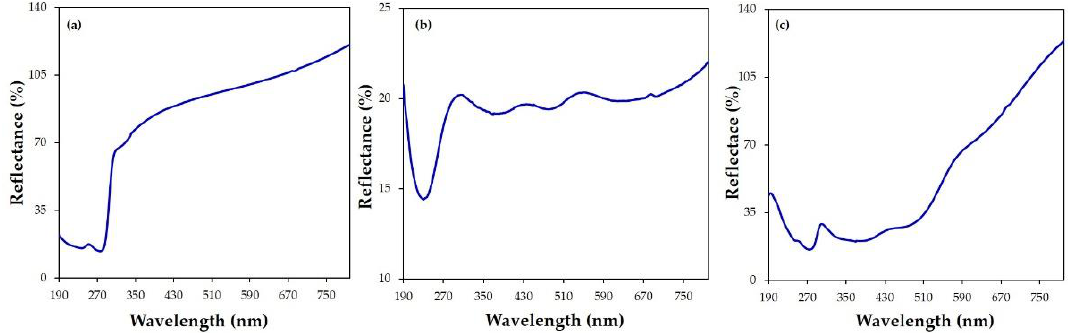
Figure 5. Reflectance (%) spectra of the ( a ) CX, ( b ) iodine, and ( c ) CX/iodine complex powders.